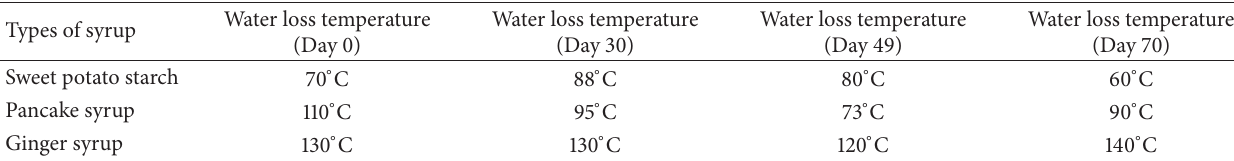
Figure 4: Water loss temperature of sweet potato, pancake and ginger syrups on Day 0 of storage. Table 2: Water loss temperatures of SPSS, pancake, and ginger